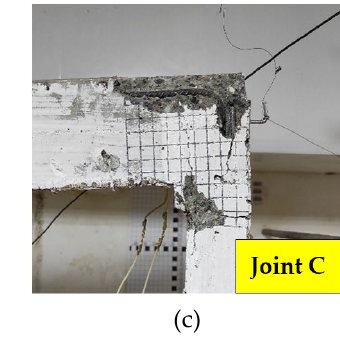
Figure 11. Video processing data for deformation and failure of the test frame under the corner column removal scenario.